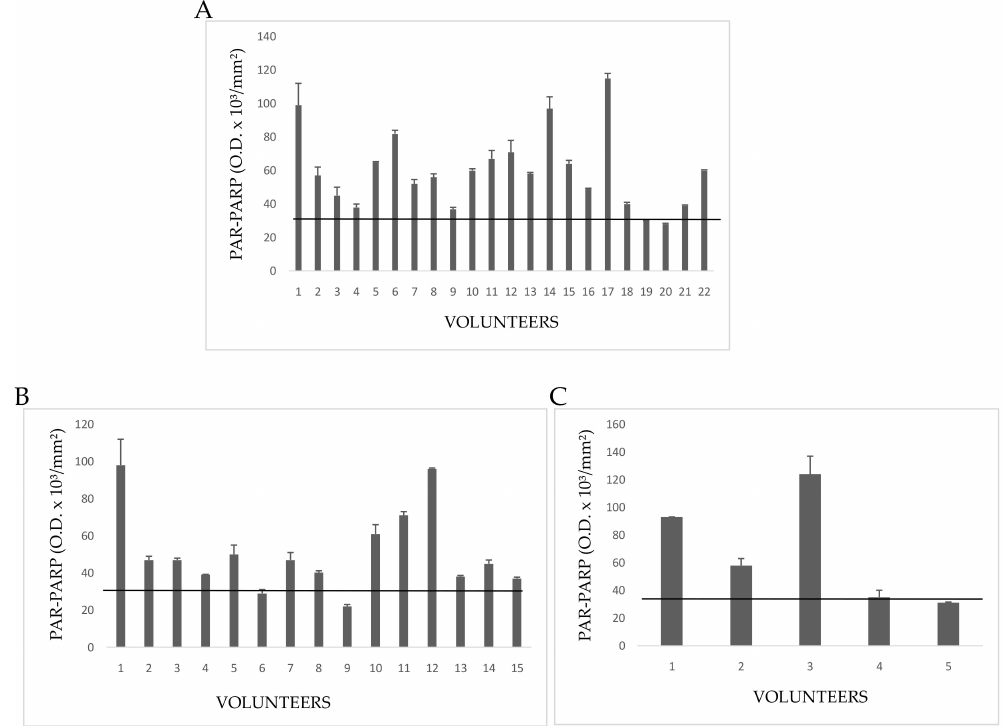
Figure 6. PAR-PARP values of exposed subjects. The black line is the cut-off. Mean values of duplicate measures from two different lysate preparations. ( A ) G1E group; ( B ) G2E group; ( C ) G3E